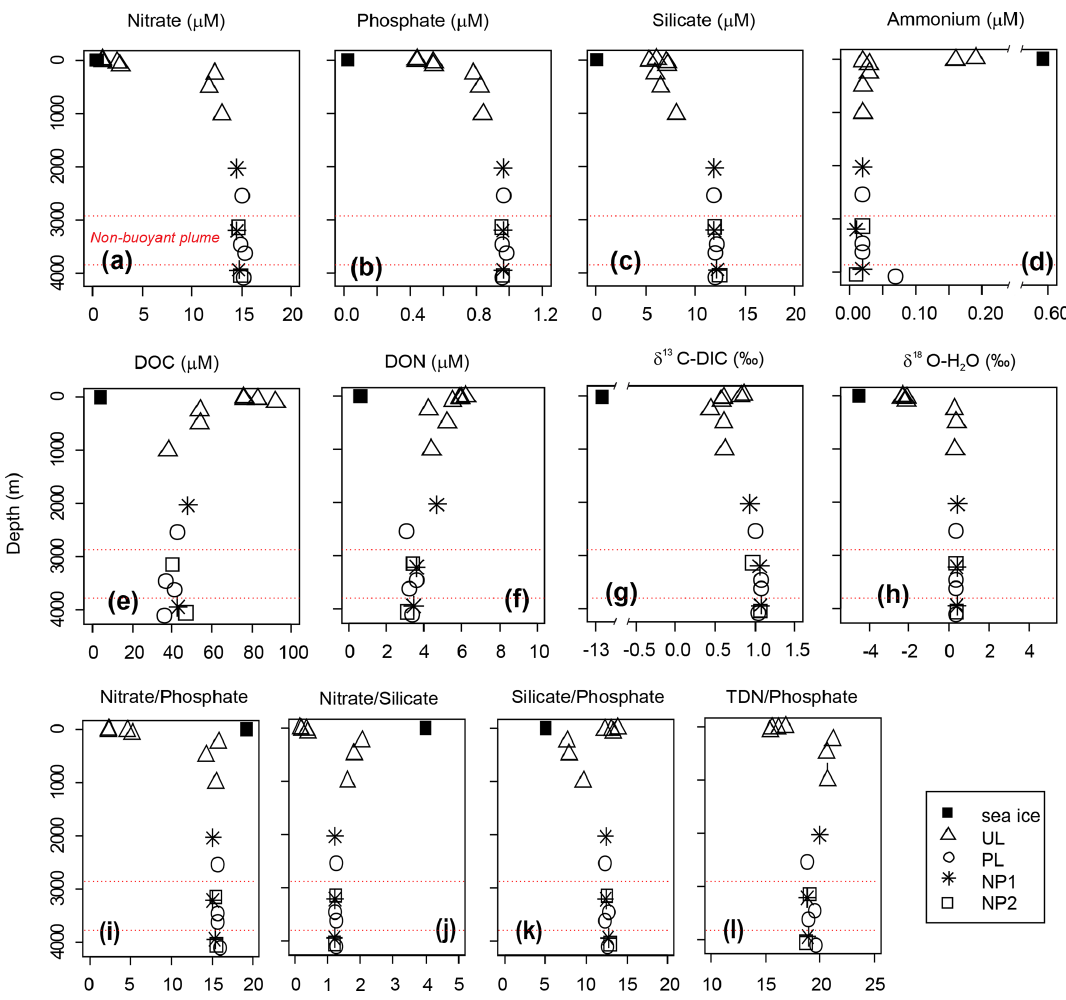
Figure 3. Depth profiles of (a–d) dissolved inorganic nutrients, (e) dissolved organic carbon (DOC), (f) dissolved organic nitrogen (DON), (g) δ 13 C of dissolved inorganic carbon (DIC) and (h) δ 18 O of water, and (i–l) nutrient ratios in sea ice and sampling stations background station (BG) and in sampling stations in the upper layer (UL), plume (PL) and non-plume (NP1, NP2). Axis breaks are used for a better visualization of ammonium concentration and δ 13 C-DIC values. Total dissolved nitrogen (TDN) = nitrate + nitrite + ammonium + DON. Red dashed lines indicate the non-buoyant plume layer at